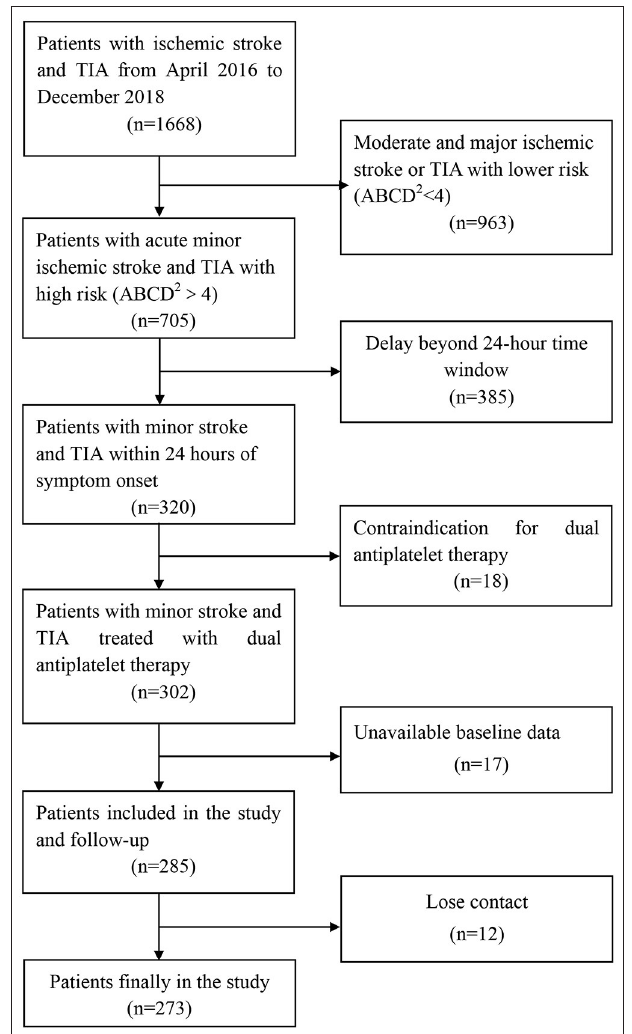
FIGURE 1 | Trial profile. TIA, transient ischemic